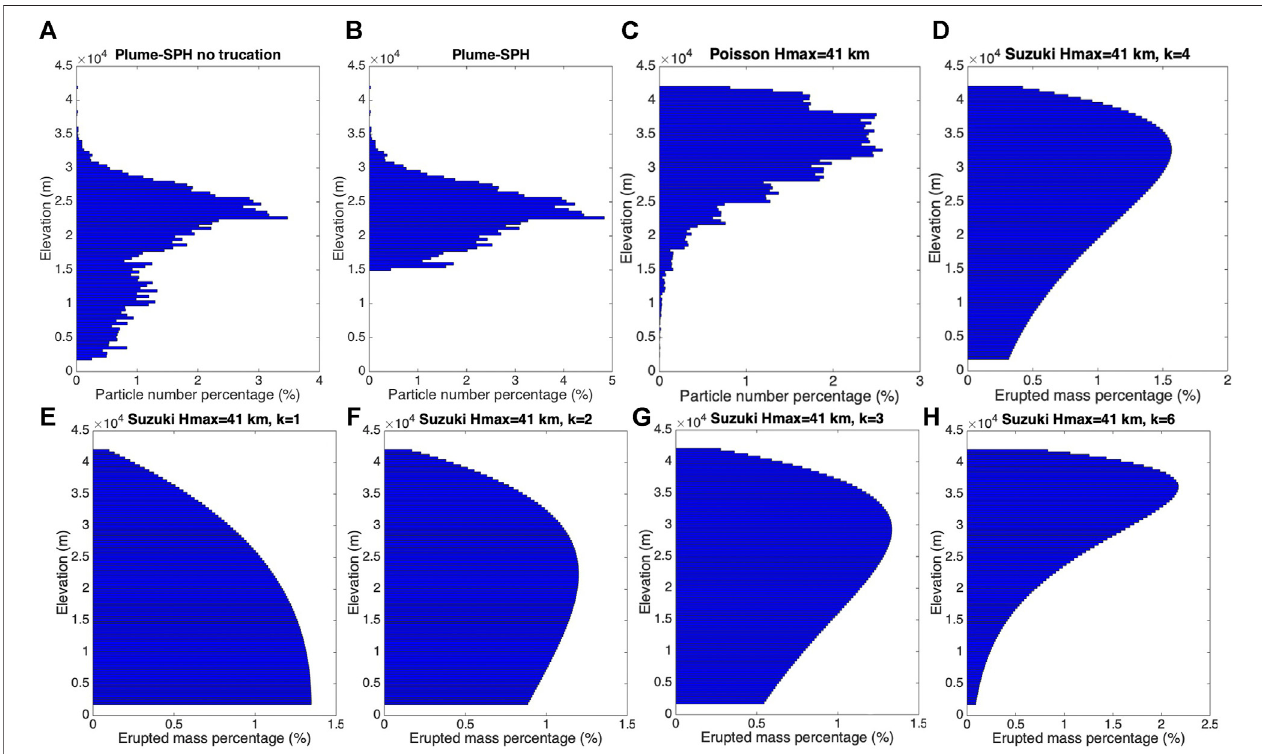
FIGURE 7 | First row, comparison of particle distribution of initial ash cloud in vertical direction. (A) is corresponding to the initial ash cloud obtained from Plume- SPH output. (B) is (A) truncated by a elevation threshold of 15 km. (C) is for vertical ash distribution based on Poisson distribution ( Eq. 13 ) with H max equals to 40 km. Another parameter, H width is 6662 m. (D) is corresponding to Suzuki distribution ( Eq. 14 ) with H max equals to 40 km and k equals to 4 (Pfeiffer et al., 2005). The second row, Suzuki distribution with H max equals to 40 km but different values for k . The x axis is the percentage of particle numbers for Plume-SPH and Poisson. For Suzuki, the x axis is the mass percentage of erupted